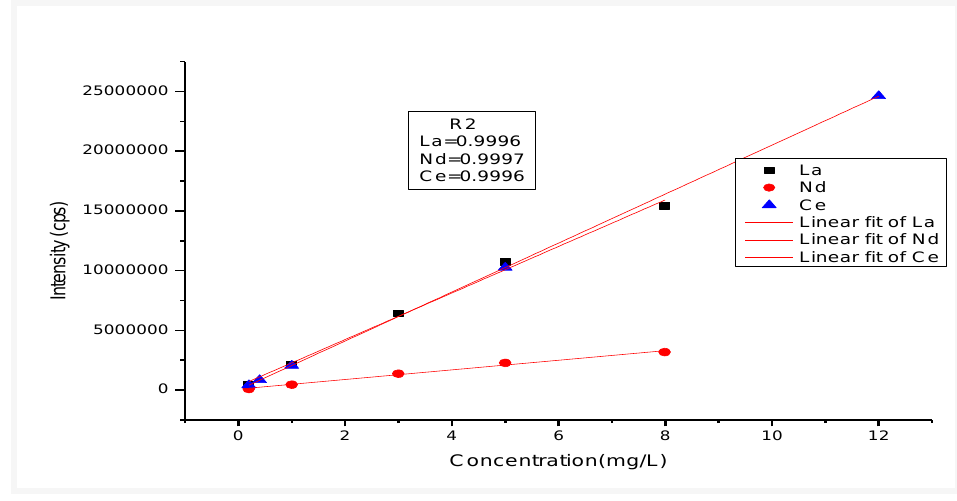
Figure 2. Regression plots obtained for LREEs at various concentration ranges.